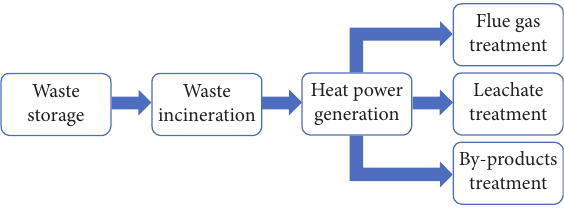
Figure 1: MSWI process.